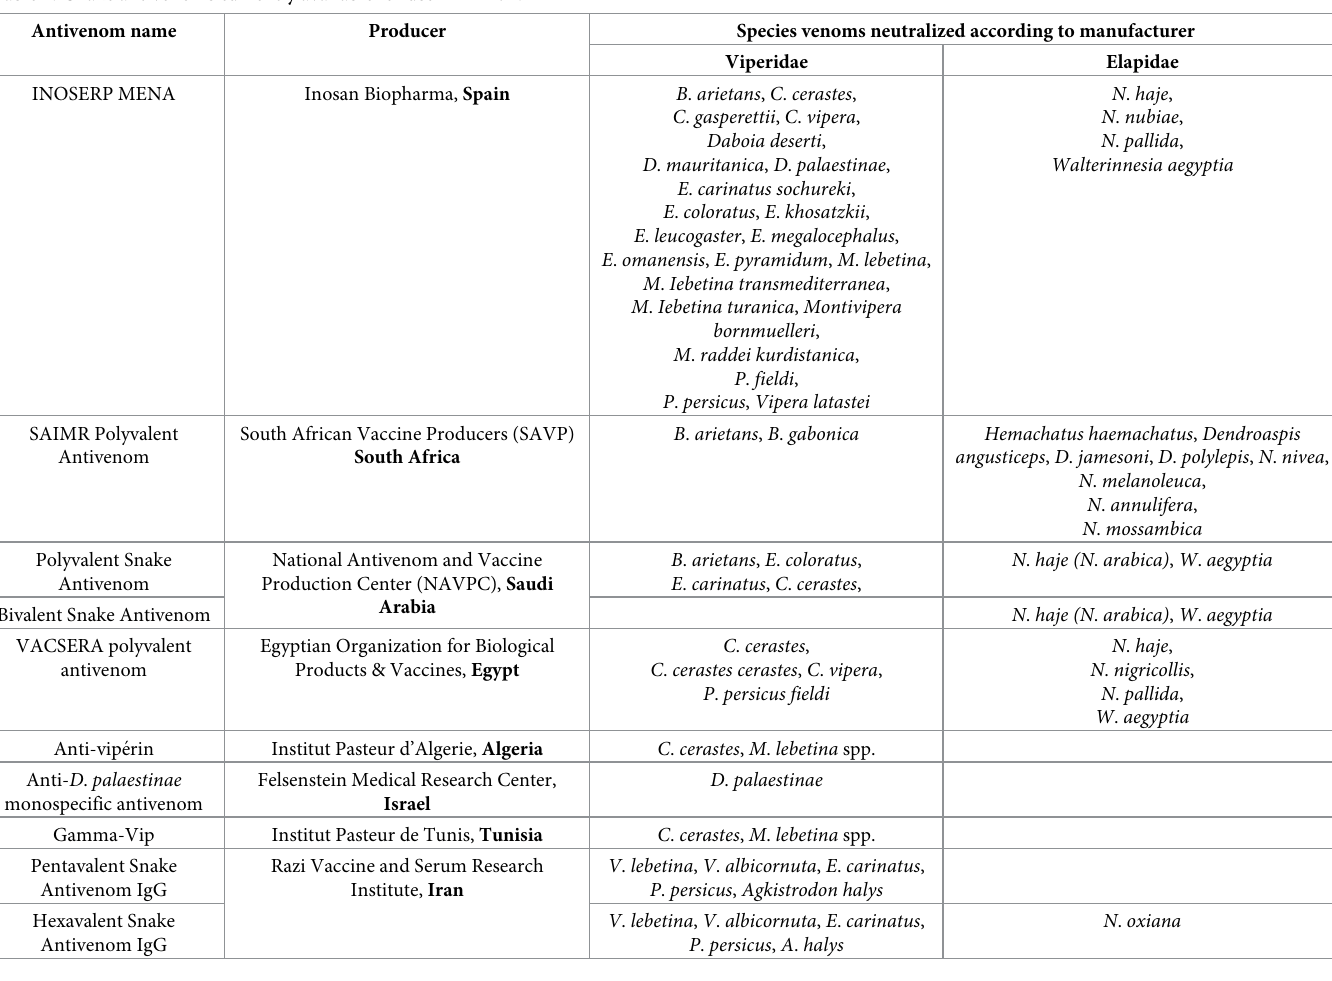
Table 1. Snake antivenoms currently available for use in